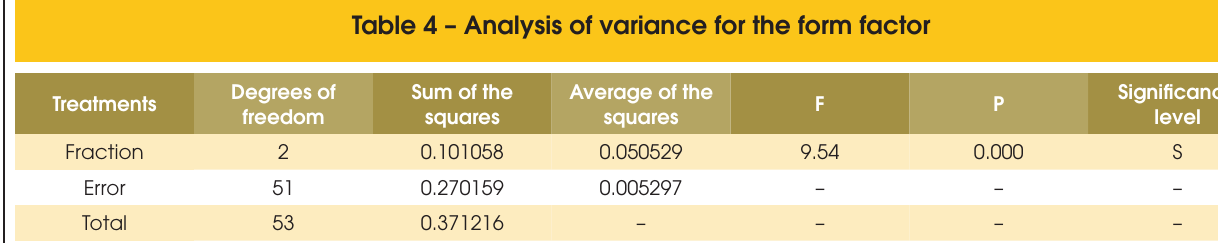
Table 4 – Analysis of variance for the form factor